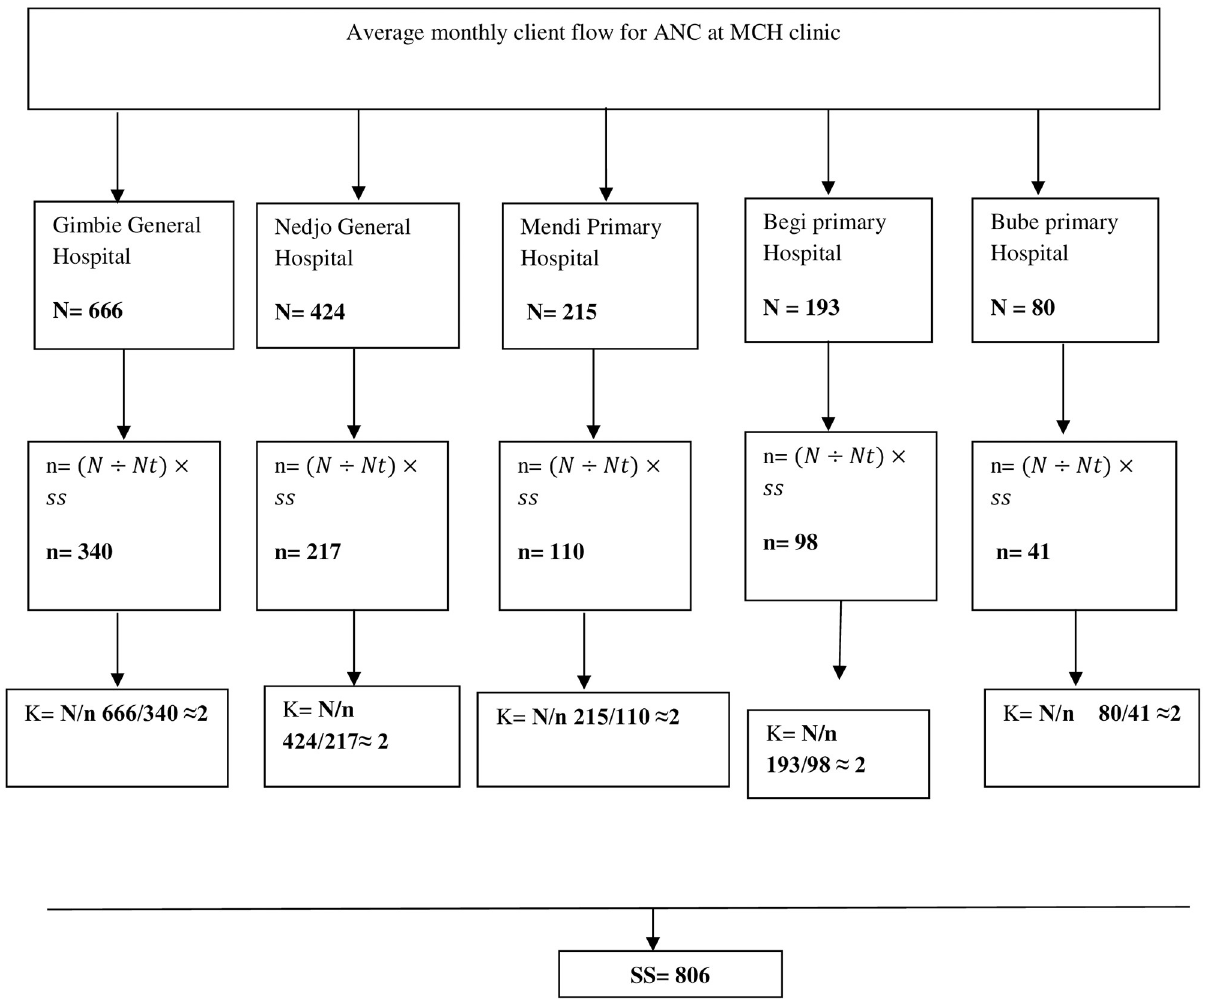
Fig 1. Proportional allocation of sample size for assessment of under nutrition among pregnant women at public hospitals of West Wollega Zone.